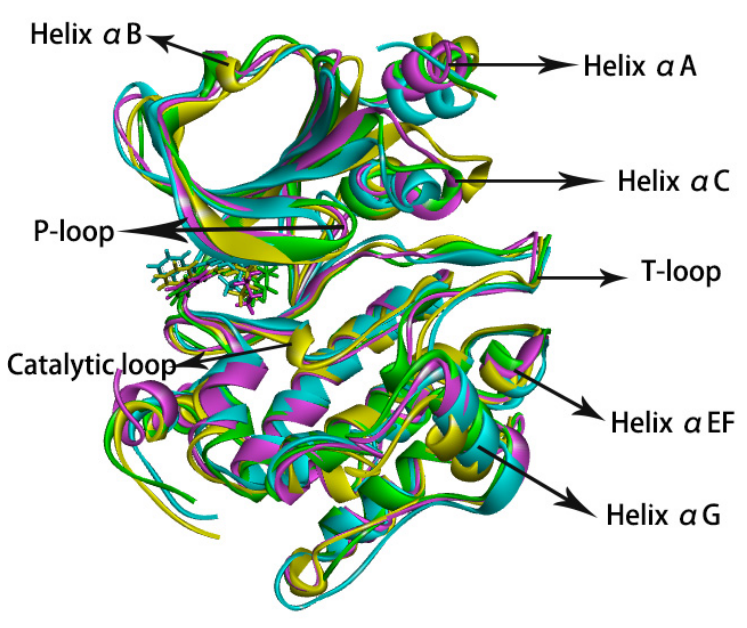
Figure 6. The conformational overlap of four complexes. Complex 5n is shown as green, Complex 5h is shown as pink, Complex 5g is shown as yellow, and Complex 5e is shown as cyan.